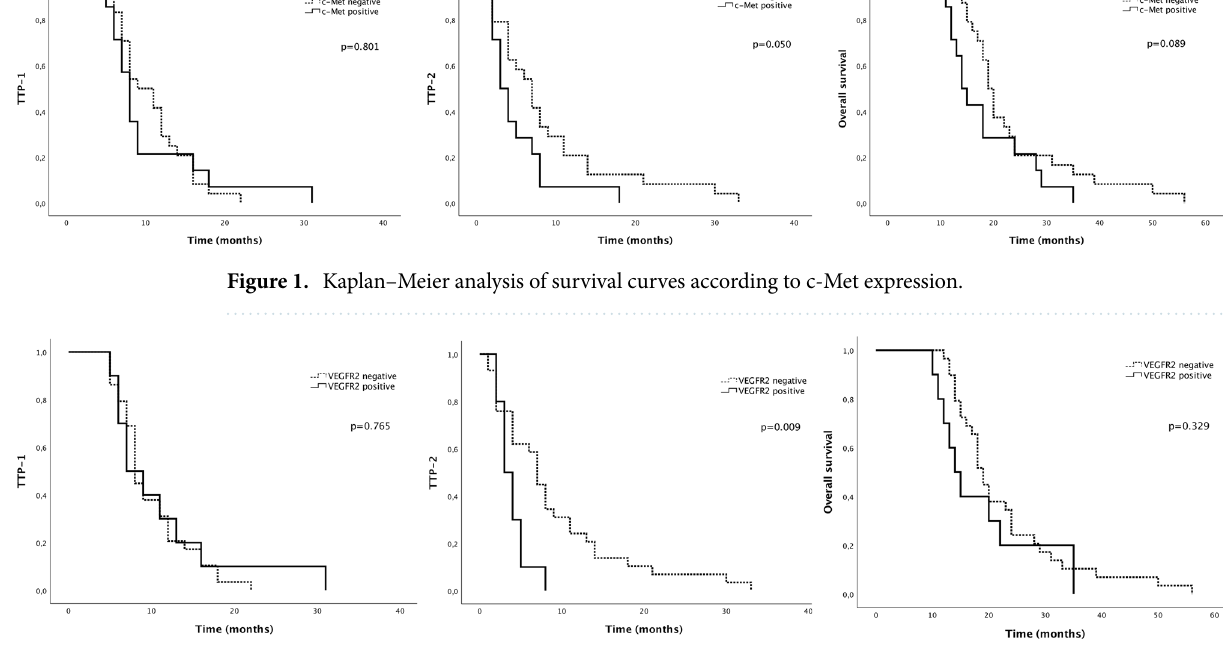
Figure 2. Kaplan–Meier analysis of survival curves according to VEGFR2